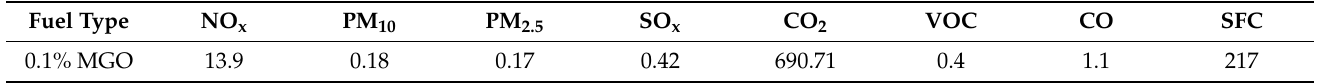
Table 4. AE emission factors (g/kWh) for hoteling USA EPA 2009 [4].